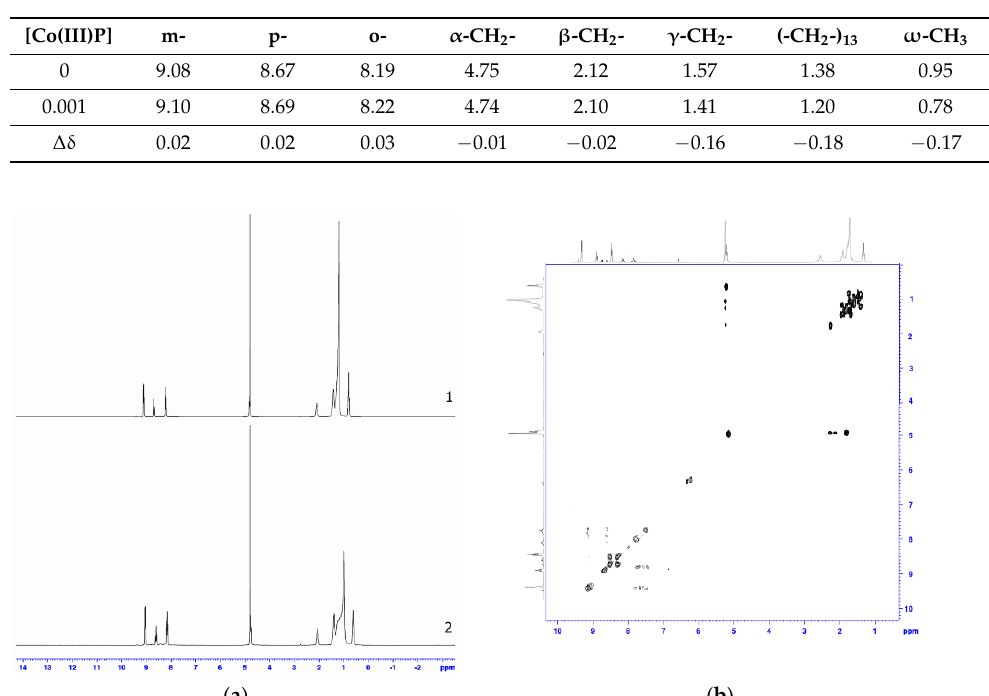
Table 4. Chemical shift of CPC protons in D 2 O/H 2 O in the presence and absence of Co(III)P1 (C CPC = 1 × 10 − 4 M).